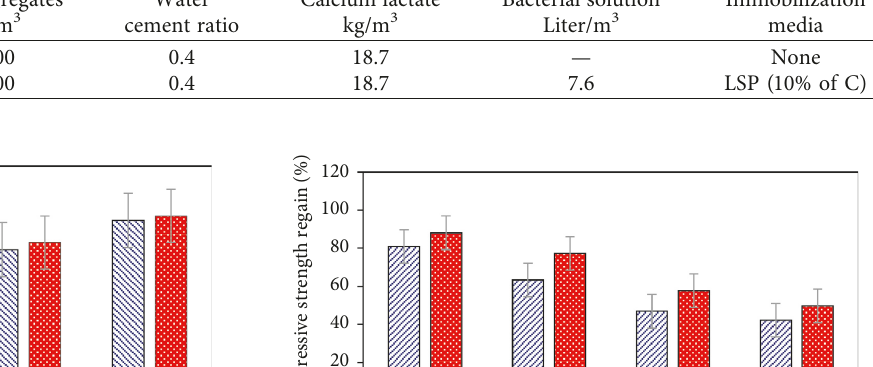
Table 2: Mix proportions of mortar formulations having mixing ratio of (1:1.4) with w/c of 0.4. Specimens